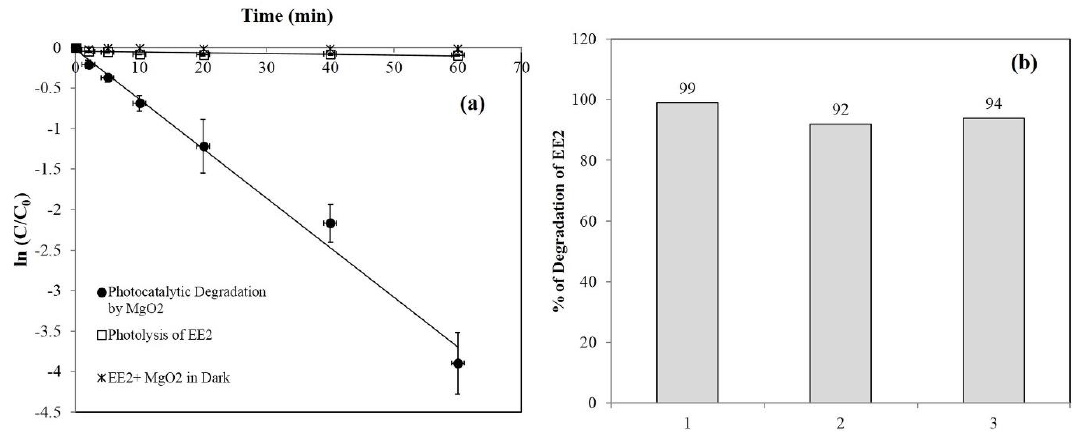
Figure 5. ( a ) Kinetics of photocatalytic and photolysis of 3 ppm EE2 in 10 mM phosphate buffer under LP-UV irradiation. ( b ) Reusability of MgO 2 for degradation of 3 ppm EE2 in 10 mM phosphate buffer under LP-UV irradiation.